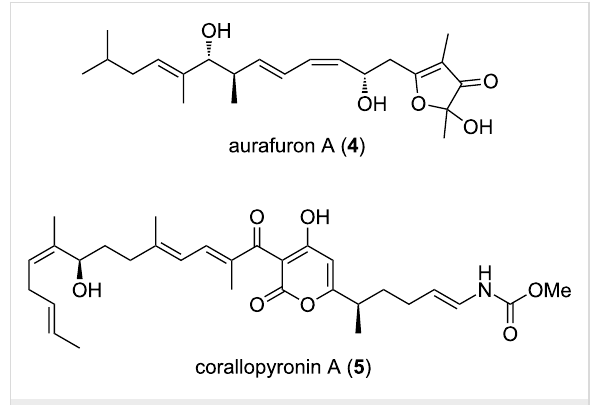
Figure 2: Structures of aurafuron A and corallopyronin A.